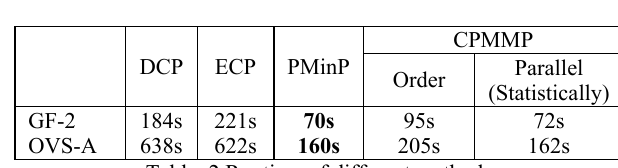
Table. 1 LR values of different methods